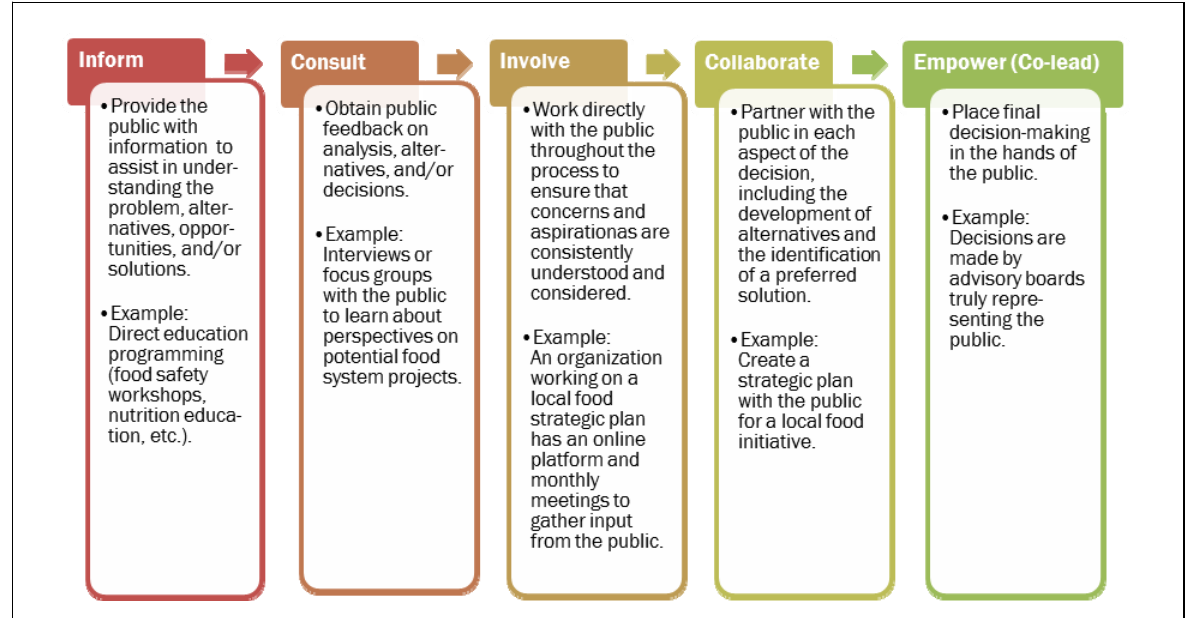
Figure 1. The Public Participation Spectrum, Followed by an Example of How Each Level Might Occur in Food Systems